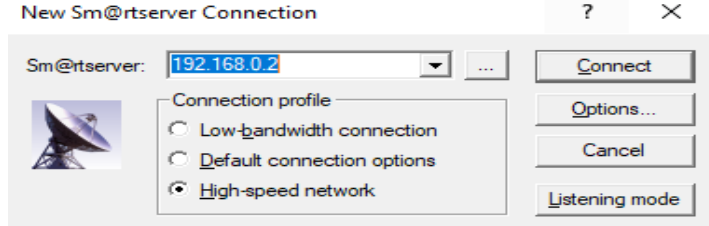
Figure 16. Enter IP to make the connection. 3. Enter password (Figure 17).